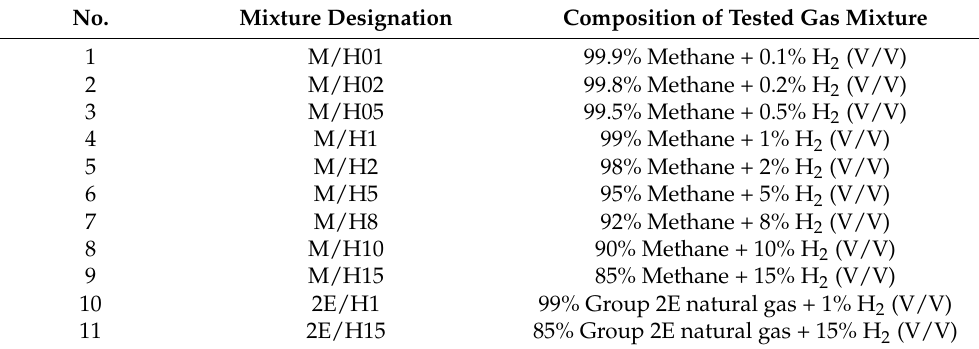
Table 4. Listed compositions of the studied gas